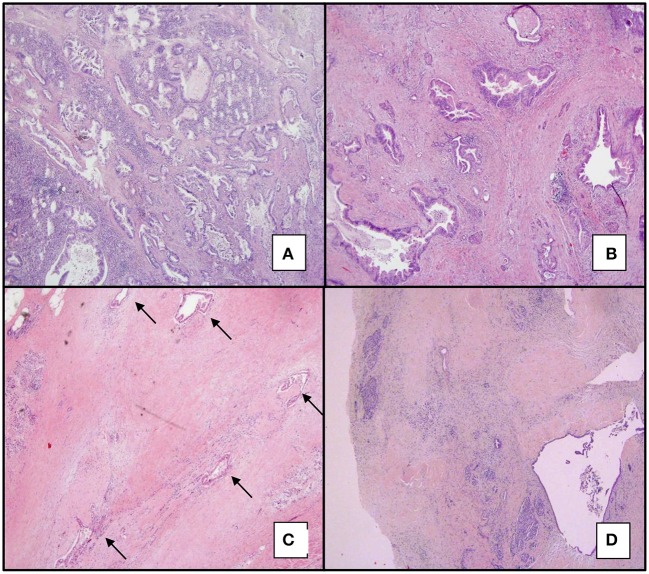
iDworak TRG system applied to PCs. (A) (4x): dominant tumor mass with poor fibrosis. (Grade 0). (B) (4x): dominant tumor mass with obvious fibrosis (Grade 1). (C) (4x): few tumor cells or groups (easy to find, Grade 2); arrows indicate neoplastic glands. (D) (4x and 20x): very few tumor cells (difficult to find microscopically, Grade 3); in this case neoplastic cells were detected in only one slide. Total response (corresponding to score 4) was not present in our group of patients.